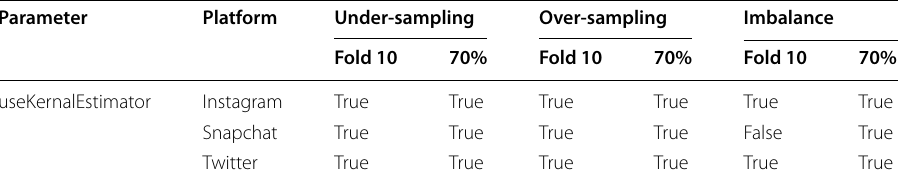
Table 6 Optimal parameter for Naive Bayes model Parameter Platform